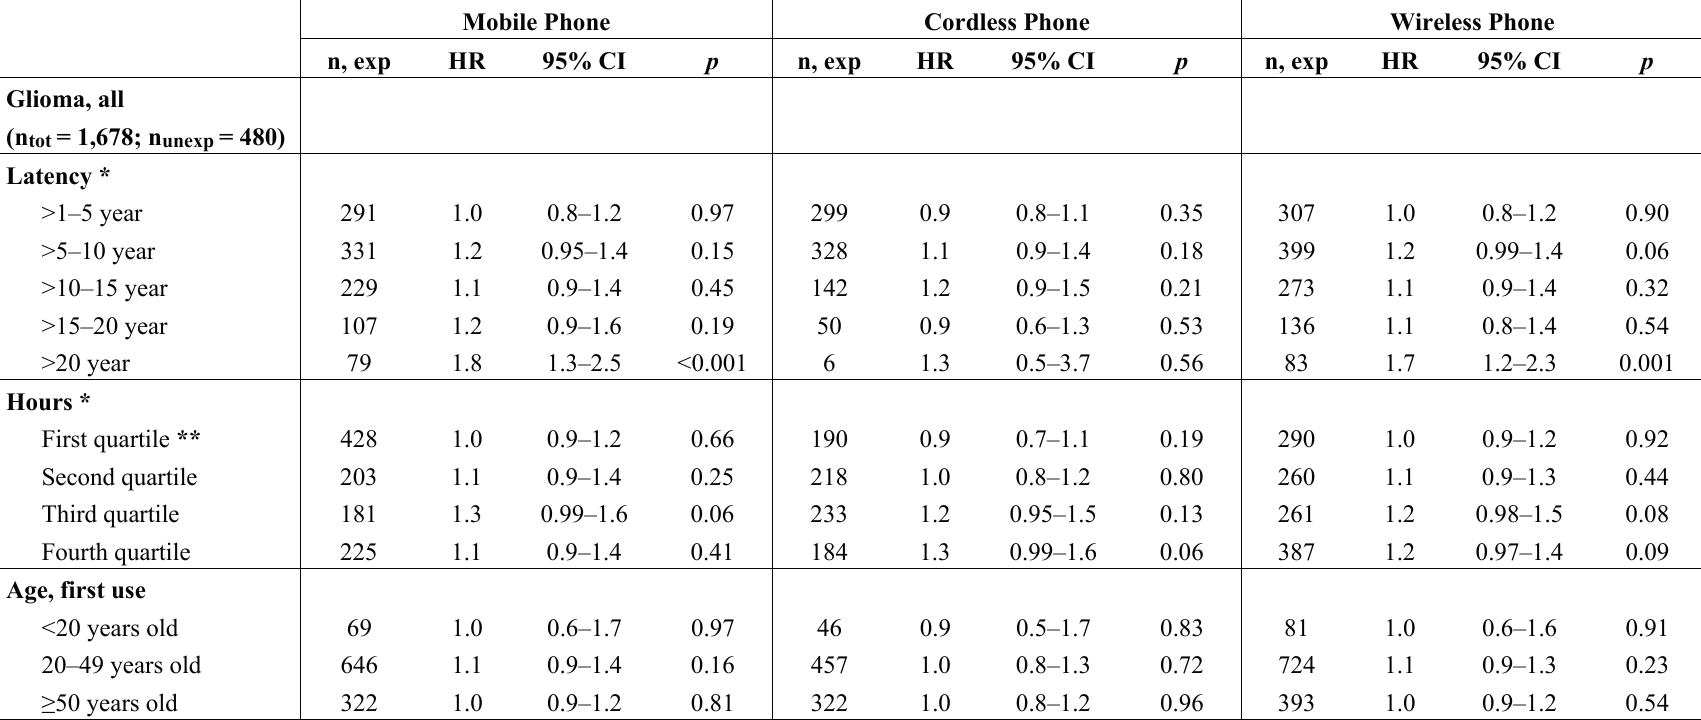
Table 3. Hazard ratio (HR) and 95% confidence interval (CI) from the Cox proportional hazards model for all glioma and for astrocytoma grade IV and use of mobile and cordless phones in different latency groups, quartiles of cumulative use, and age at first use. Adjustment was made for age, gender, year of diagnosis, SEI-code, study, and age as a time-dependent